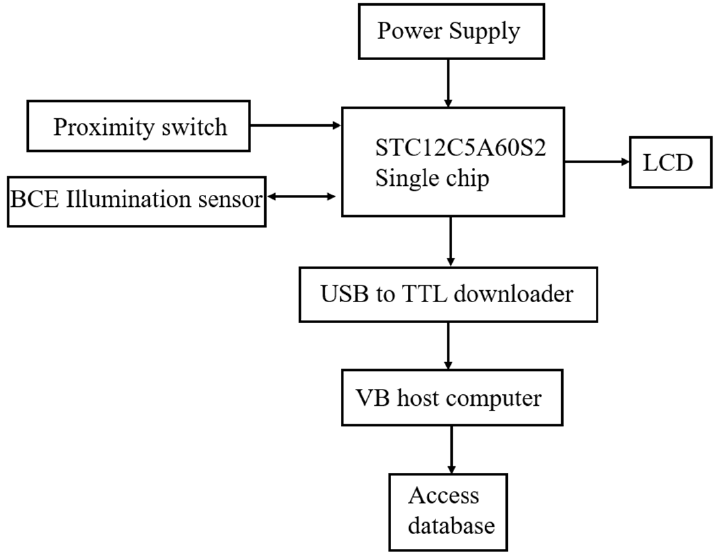
Figure 2. Hardware design principle block diagram of measuring device.